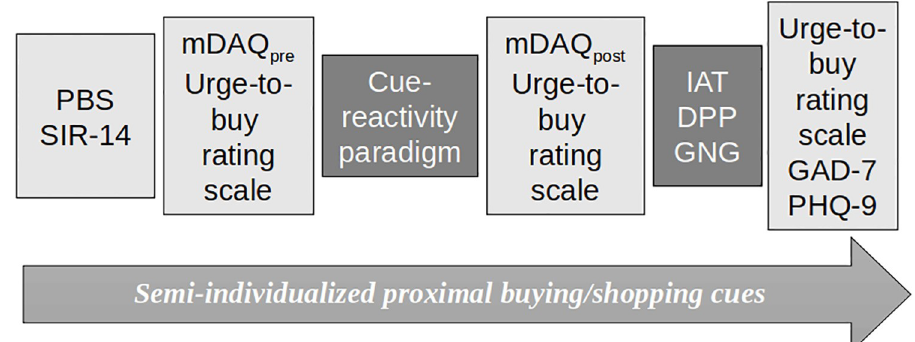
Fig 1. Study procedure. PBS = Pathological Buying Screener, SIR-14 = Saving-Inventory-Revised (without acquisition items), mDAQ = modified Desires of Alcohol questionnaire, GAD-7 = General Anxiety Disorder questionnaire, PHQ- 9 = Patient Health Questionnaire depression